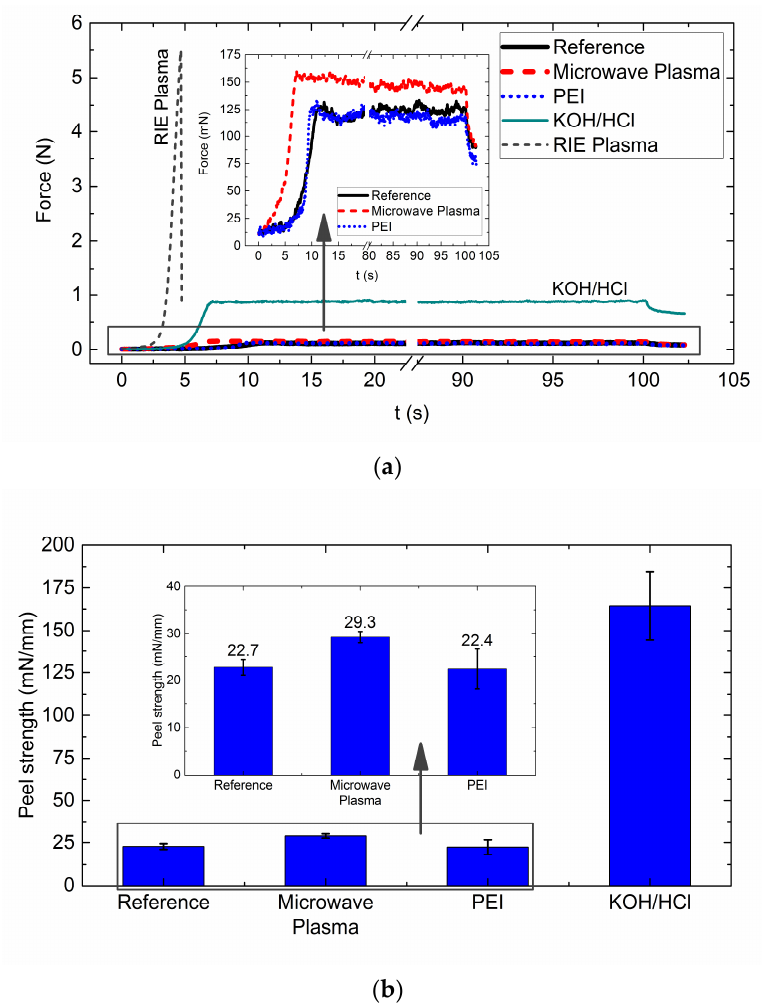
Figure 6. Peel test of results of PI films: ( a ) Representative force plot of samples; ( b ) Average peel strength.